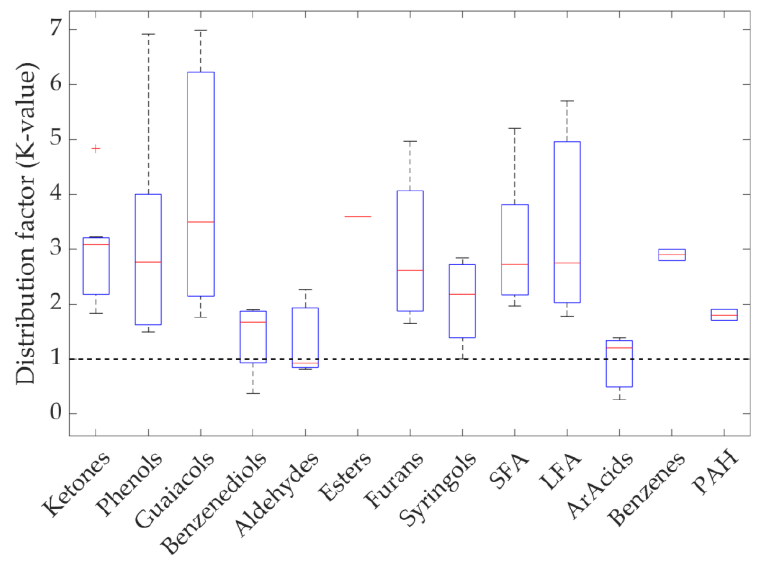
Figure 7. Distribution factors (K-values) of component classes identified in the literature. K-values correspond to the pressure, temperature, and compositional ranges reported in the literature. The boxes include the 50% distributed around the average, the red line is the median value, the whiskers are the extreme values (over 75% and under 25%), and the “+” denotes values considered outliers [58,64,84,126,127,129,130]. SFA, short chain fatty acid; LFA, long chain fatty acid; PAH, polyaromatic hydrocarbon.